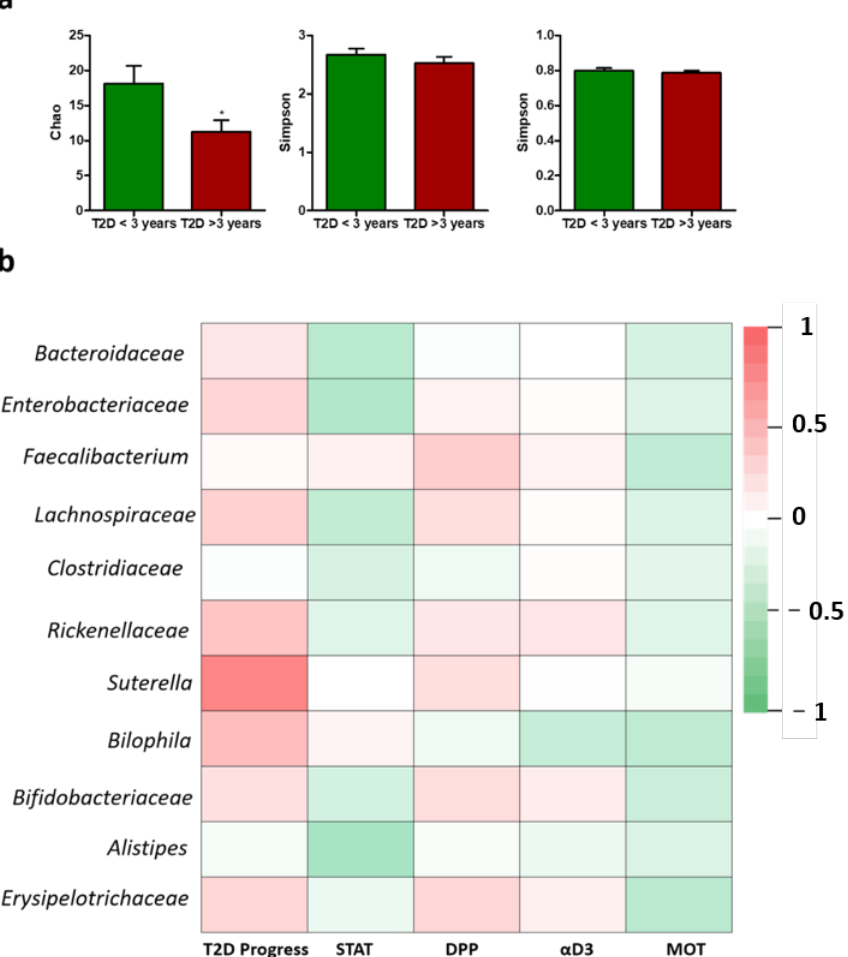
Figure 4. ( a ). Alpha microbiome diversity in T2D patients—Chao1, Shannon index, Simpson index. ( b ). Correlations between T2D chronicity, medication use and the top OTUs in type 2 diabetes patients. Red indicates a positive correlation, green indicates a negative correlation, while white indicates no correlation.